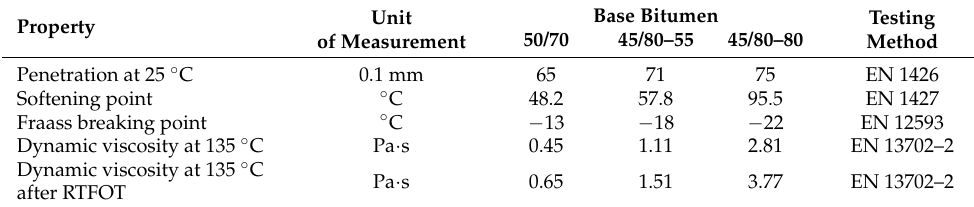
Table 1. Properties of the base asphalt binders used in the study.